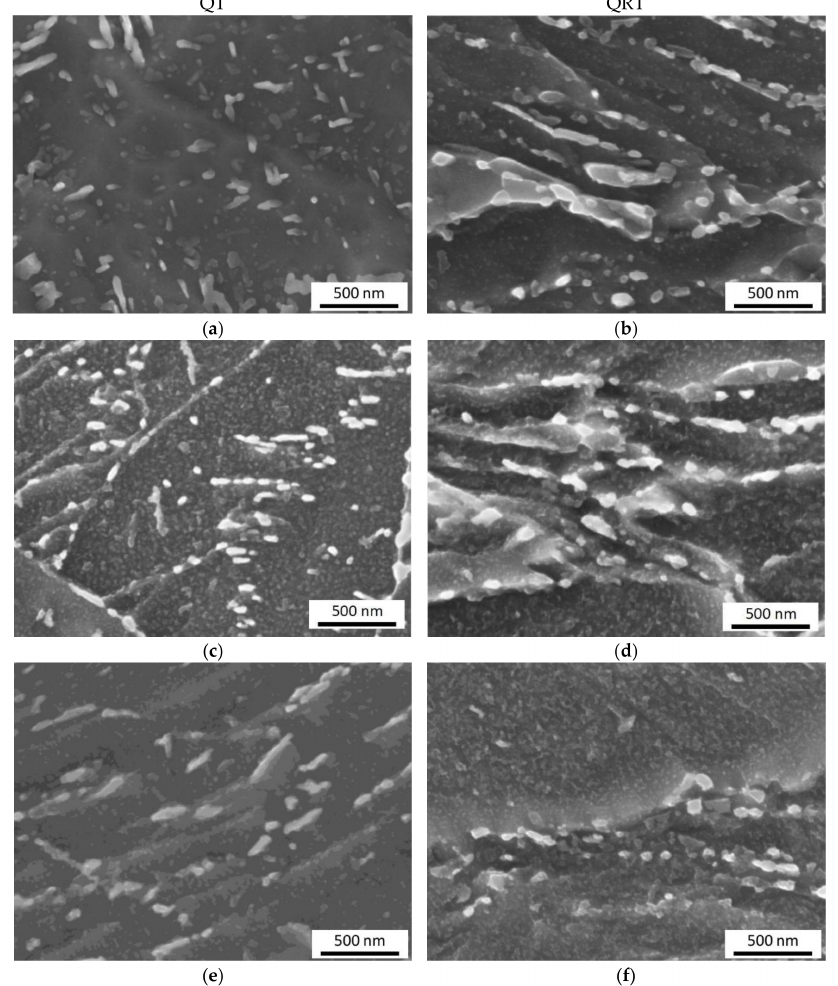
Figure 5. Microstructures of the samples after tempering at 500 ◦ C for 1 h: ( a ) 0Cu QT; ( b ) 0Cu QRT; Figure 6 is a TEM image of a thin foil from the QT 500